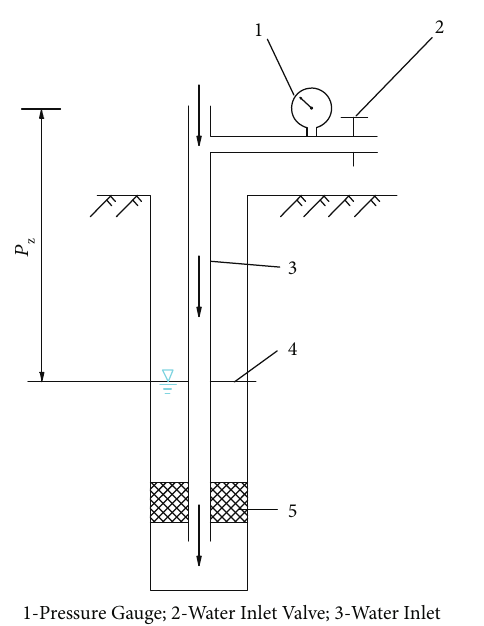
Figure 4: Schematic representation of the water pressure